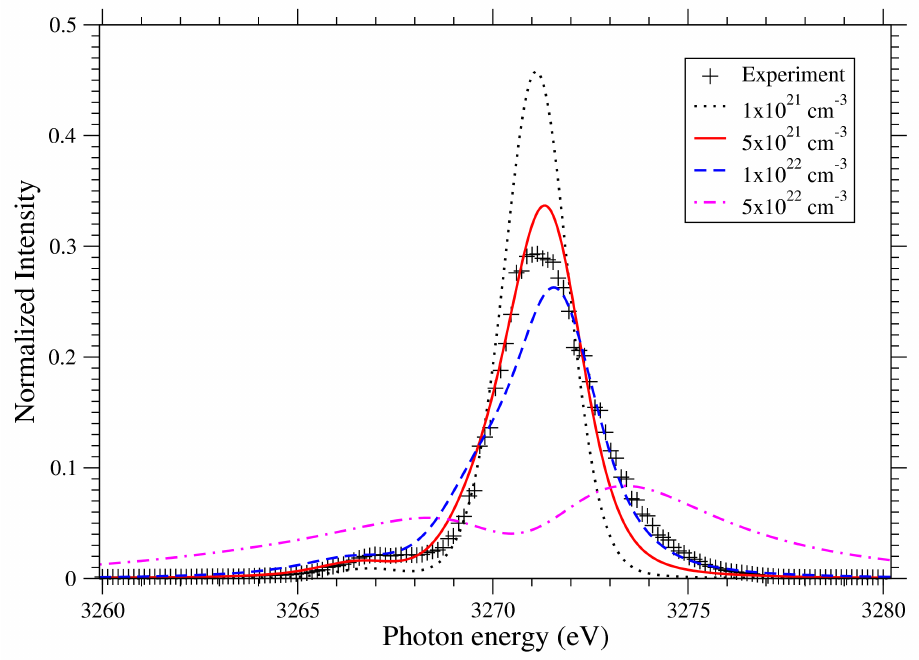
Figure 9. Analysis of the Chlorine He- β profile measured on the ORION laser facility [36]. The ZEST calculations are performed for a LTE plasma at T i = T e = 440 eV and various electron density N e . An experimental Gaussian FWHM of 2 eV is taken into account in the